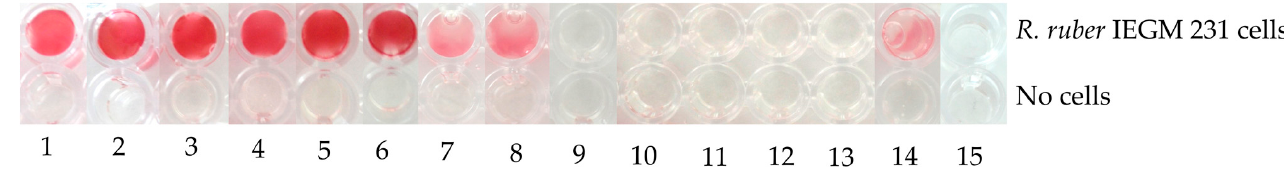
1227 were tested. 2 R. jostii IEGM 1193 and R. pyridinivorans IEGM 1137 were tested.